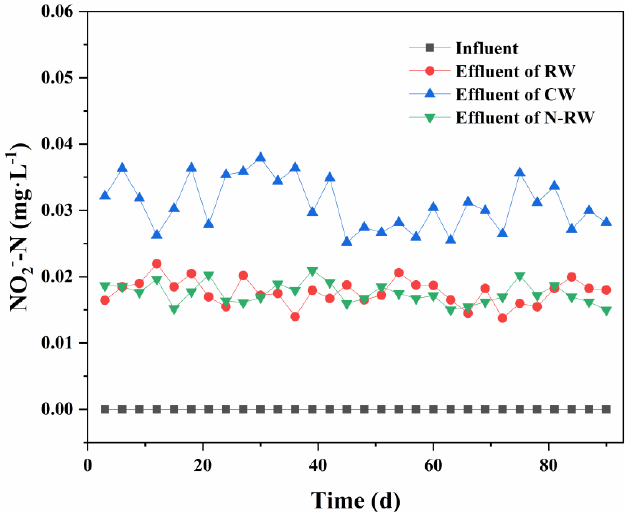
Figure 4. Changes of NO 2 − -N concentration in influent and effluent of three groups of wetland sys- tems. The comparison between RW and N-RW showed that reed planting had no signifi- cant effect on NO 2 − -N removal in constructed wetlands ( p > 0.05). This may be due to the small number of reeds planted in RW in this experiment, which did not have a significant impact on NO 2 − -N removal. The main limiting factor in the wetland denitrification process was still whether the organic carbon source was sufficient [28]. 3.2. Effects of Reed Carbon Source on COD and pH of Constructed Wetland Effluent 3.2.1. Changes in COD of Wetland Effluent It can be seen from Figure 5 that the COD concentration of the influent from RW, CW and N-RW was 29.15 – 36.45 mg/L and the COD concentration of the effluent was 26.06 – 29.75, 12.49 – 19.99 and 38.34 – 49.60 mg/L, respectively. The corresponding average re- moval rates of COD were 14.65 ± 4.35%, 48.29 ± 7.67% and − 28.17 ± 9.79%, respectively. The comparison between RW and CW showed that the addition of a reed carbon source could increase the COD concentration of wetland effluents to a certain extent, and the COD removal rate was 33.64% lower than that of CW, but the COD concentration of the effluent from RW was stable and less than 30 mg/L, which met the corresponding surface water standard, i.e., Class IV ( Environmental Standards for Surface Water Quality GB 3838- 2002, China); COD, TN, NH 4+ -N and TP should be below 30, 1.5, 1.5 and 0.3 mg/L, respec- tively [29]. This was because the reed carbon source in RW could release organic matter continuously and stably, which significantly increased the organic matter content in the wetland. Most of the organic matter was removed by substrate adsorption, microbial aer- obic degradation and denitrification consumption, and the remaining organic matter would flow out of the wetland system with the effluent [30].